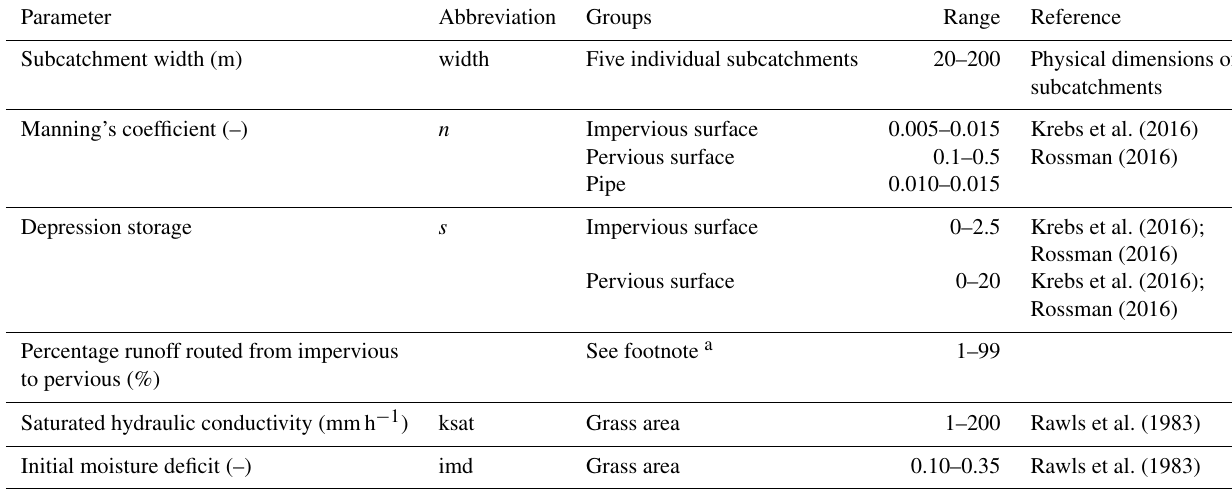
Table 3. Calibration parameters and their ranges for the low-resolution